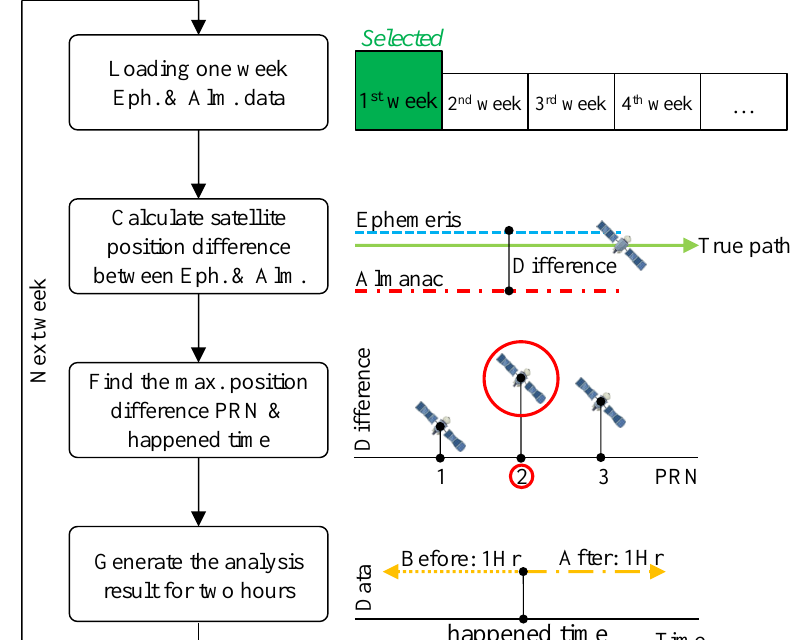
Figure 19. BDS DQA1: The flow chart for generating the applicable almanac